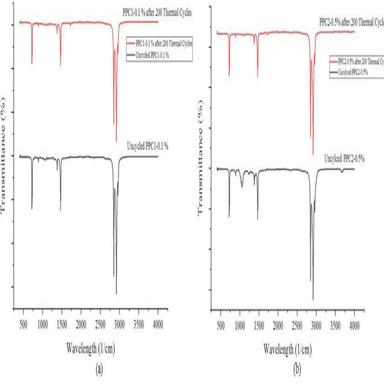
FTIR Spectrum before and after 200 Thermal Cycles a) PPC1-0.1%& b) PPC2-0.5%.